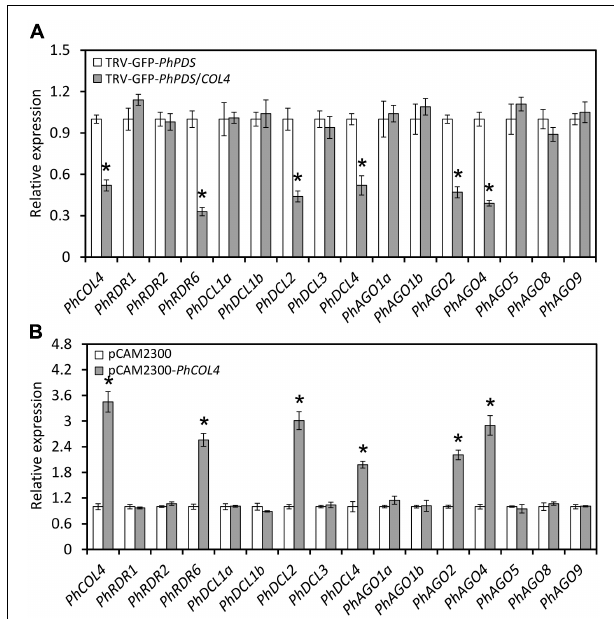
FIGURE 8 | Impact of PhCOL4 silencing and transient overexpression on RNA silencing-related genes. (A) RT-qPCR analysis of transcript levels of PhCOL4 and RNA silencing-related genes in the inoculated leaves at 4 days post inoculation (dpi) with Agrobacterium containing TRV-GFP- PhPDS or TRV-GFP- PhPDS / COL4 . (B) RT-qPCR analysis of transcript levels of PhCOL4 and RNA silencing-related genes in the infiltrated leaves at 6 dpi with Agrobacterium containing pCAMBIA2300- PhCOL4 (pCAM2300- PhCOL4 ). The empty vector pCAMBIA2300 (pCAM2300) was used as the control. Expression levels were standardized to 26S rRNA . Error bars represent standard error of the mean from three biological replicates. Significance of difference was calculated by Student’s t -test at P < 0.05 and indicated by